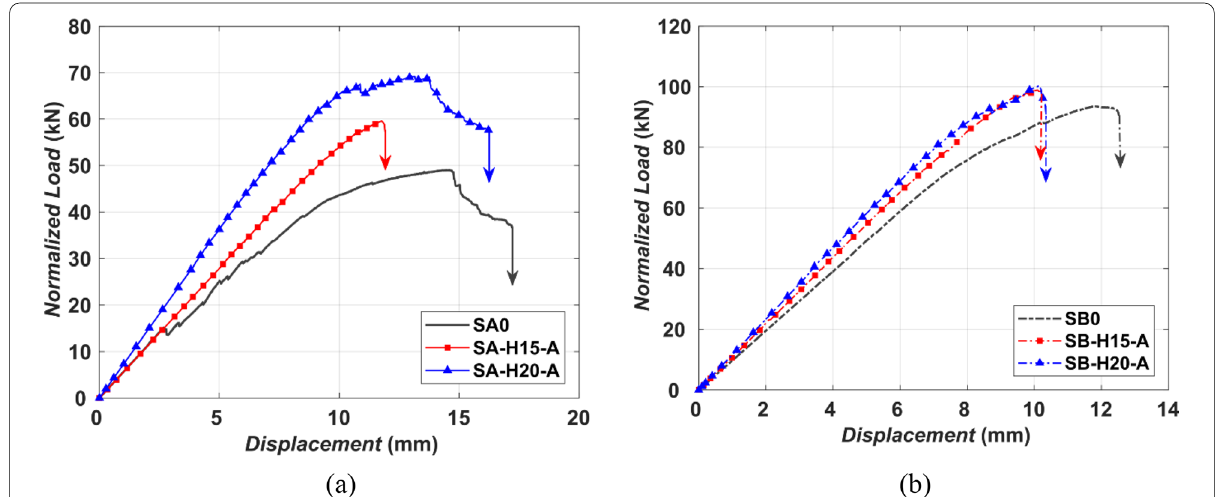
Fig. 10 Load–deflection curves of specimens with different HFRP sheet width in Group a SA; b